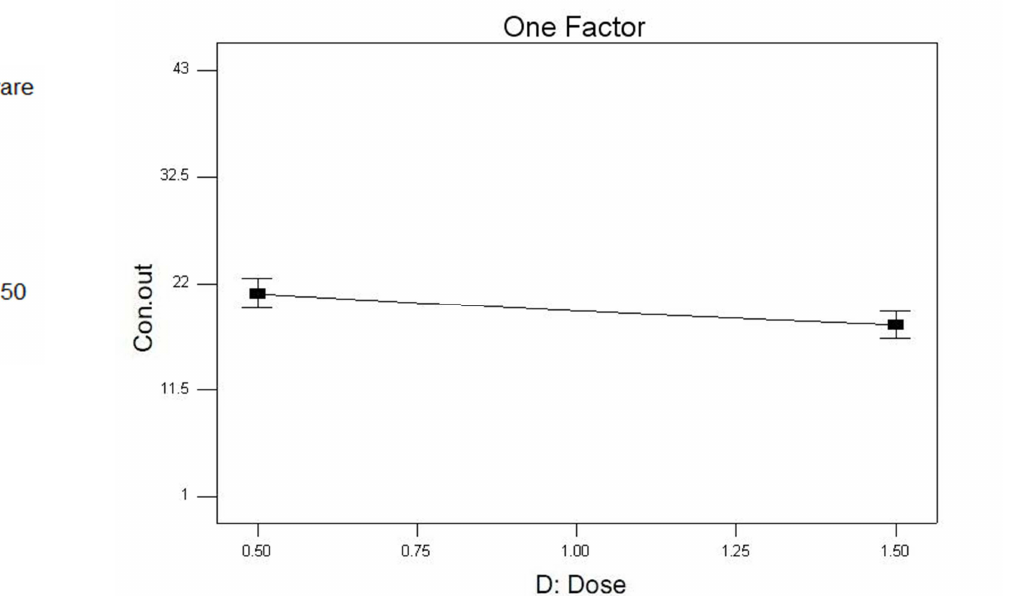
Figure 6. Response surface one factor plots showing effect of activated carbon (AC) dose (g AC/l) on humic acid (HA) removal